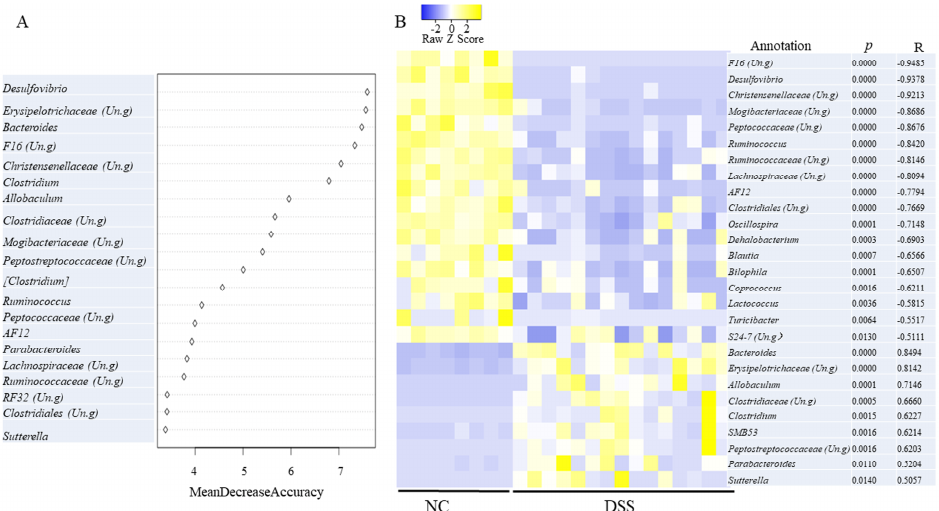
Figure 3. Microbial genera significantly related to DSS induced colitis phenotypes. ( A ) The Random Forest analysis identified important microbial genera distinguishing colitis phenotypes. Un.g: unclassified genus in a given family. ( B ) Taxa significantly correlated with the colitis status. P: significance; R: correlation coefficient.